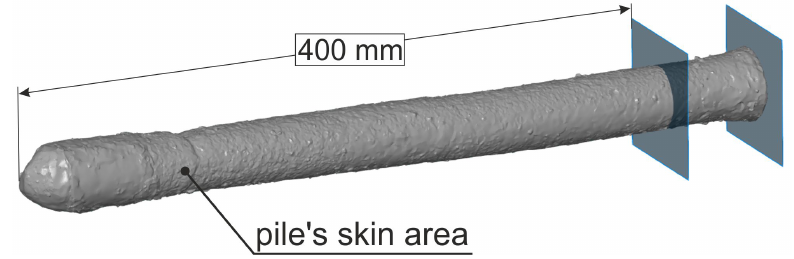
Figure 15. Pile’s skin area calculated based on the